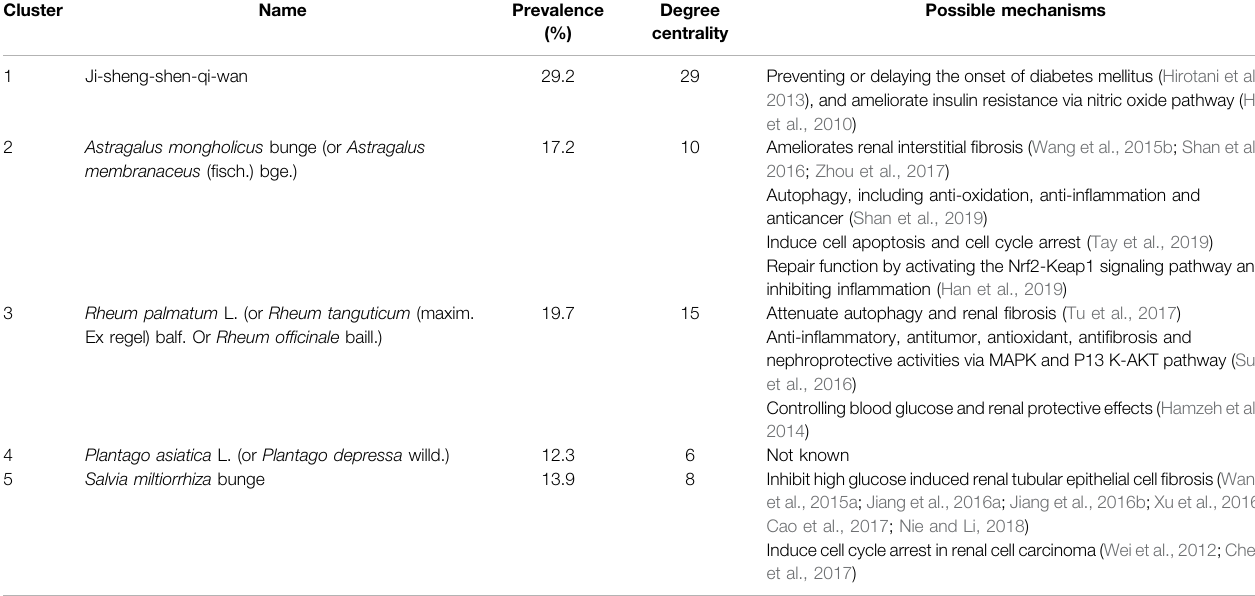
TABLE 4 | The core Chinese herbal medicine (CHM) and the potential pharmacologic mechanisms for pre-dialysis diabetic nephropathy (DN) patients.